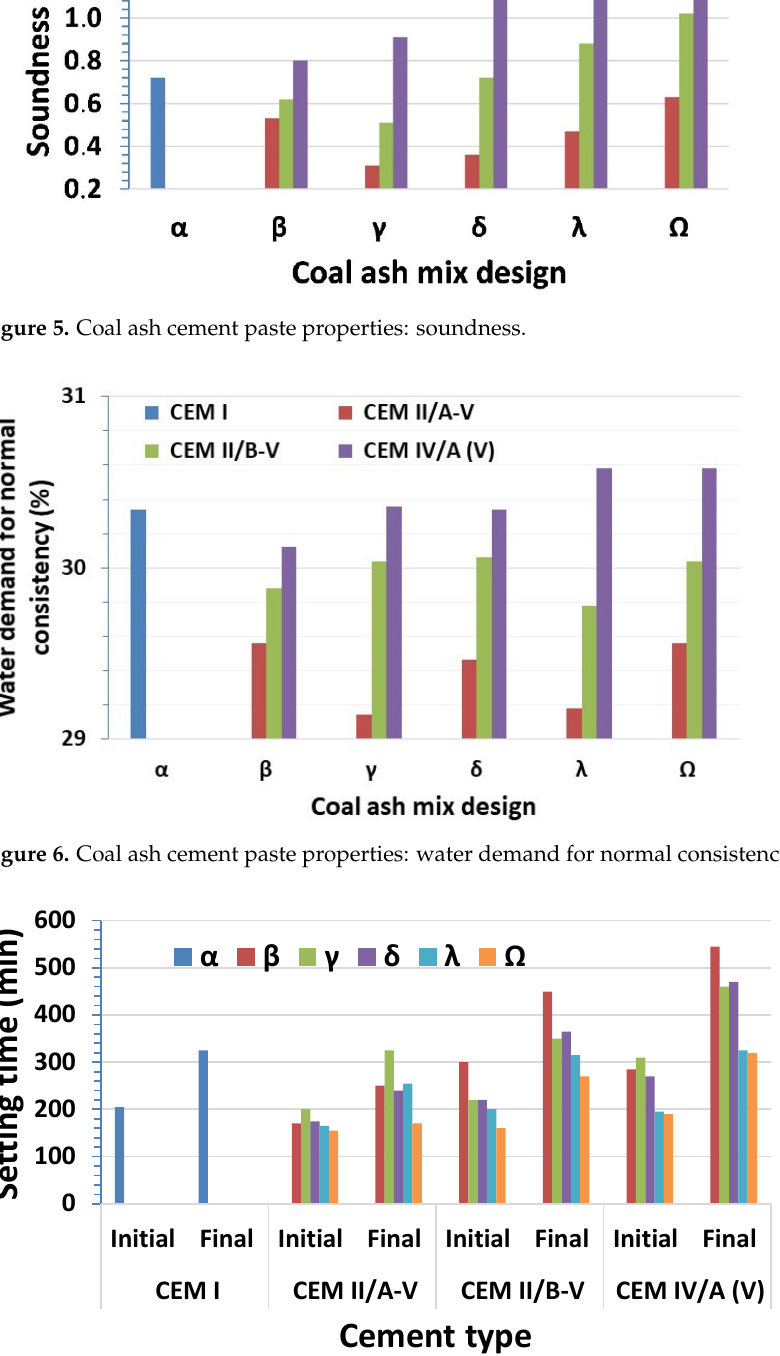
Figure 7. Coal ash cement paste properties: initial setting time and final setting time.